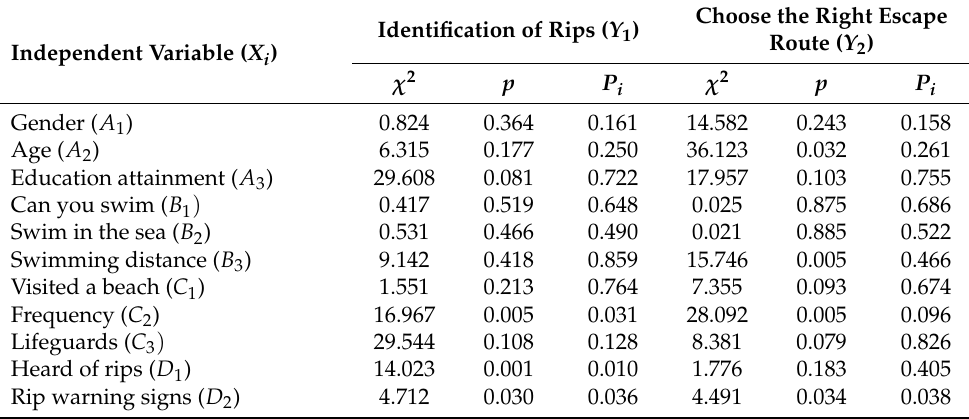
Table 4. The chi-square value between the independent and dependent variables; P i is the probability value calculated by the regression